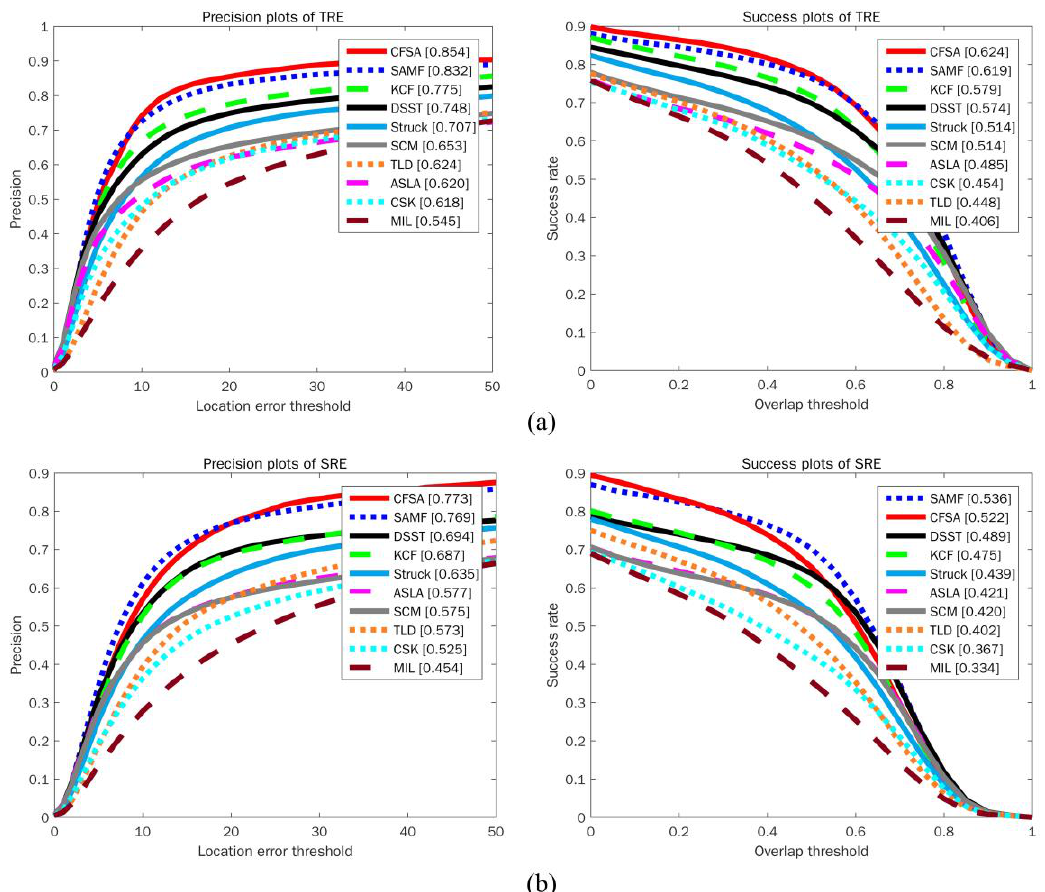
Figure 5. Precision and success plots over OOTB benchmark dataset using ( a ) temporal robustness evaluation and ( b ) spacial robustness evaluation. The performance score for each tracker is shown in the legend.